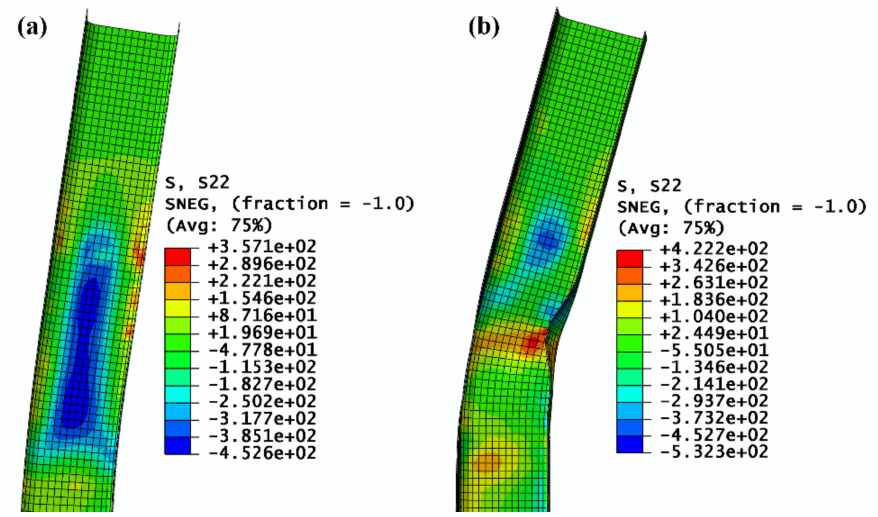
Figure 19. Distribution of the circumferential stress with different push speeds of the bending roller (distance between the inductor and the bending roller: 50 mm): ( a ) 1.25 mm/s; ( b ) 10 mm/s.